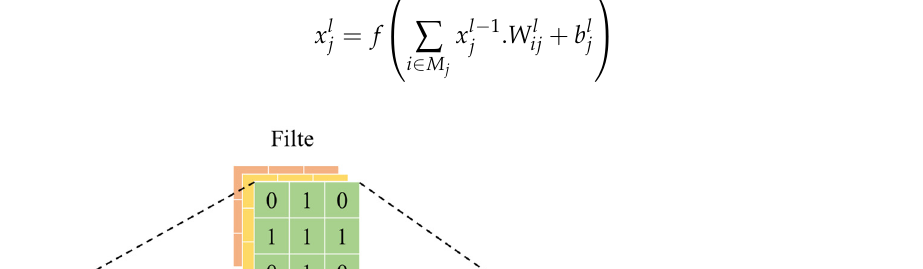
Figure 12. A CNN architecture .